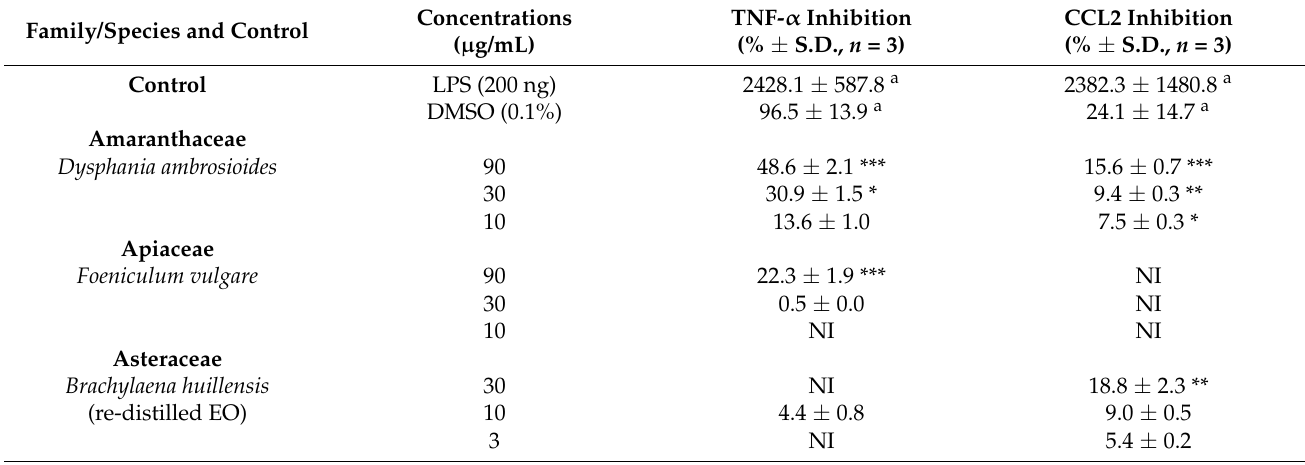
Table 4. Inhibition of TNF- α and CCL2 production by lipopolysaccharide (LPS)-activated THP-1 monocytic cells elicited by the evaluated essential oils (EOs). Family/Species and